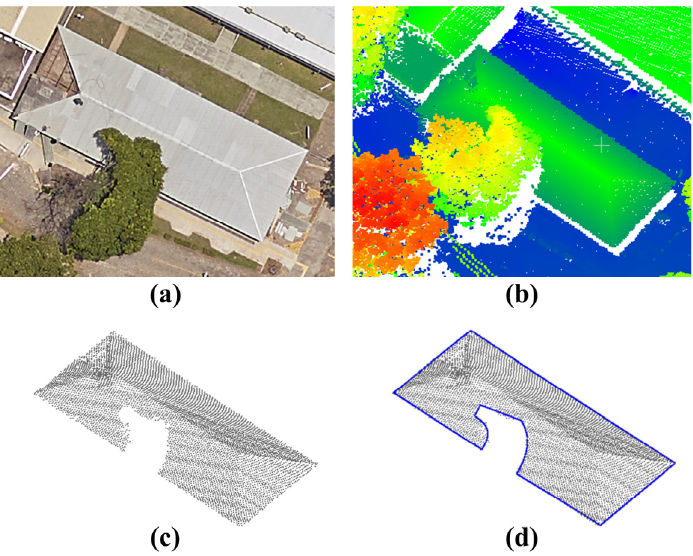
Figure 1. Building partially covered by a tree and modeled boundary using the ICDS method. Aerial image ( a ), airborne LiDAR data ( b ), and sampled points on the roof building ( c ) and modeled contour ( d ).